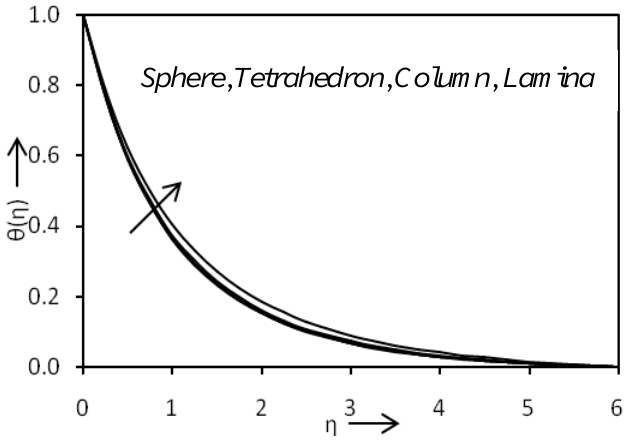
Figure 7. Variation of different shapes of solids on the temperature profiles with